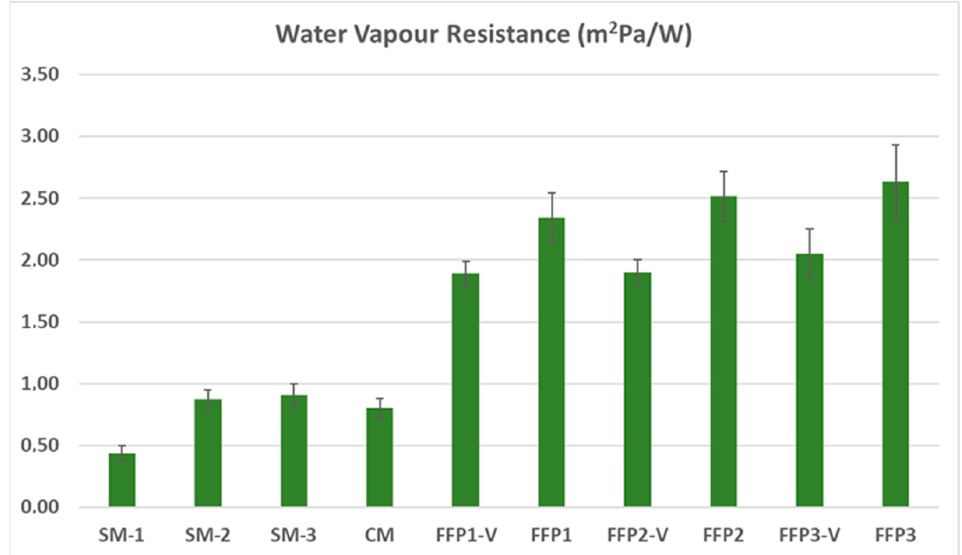
Figure 6. Water vapor resistance results of the masks used in the study.